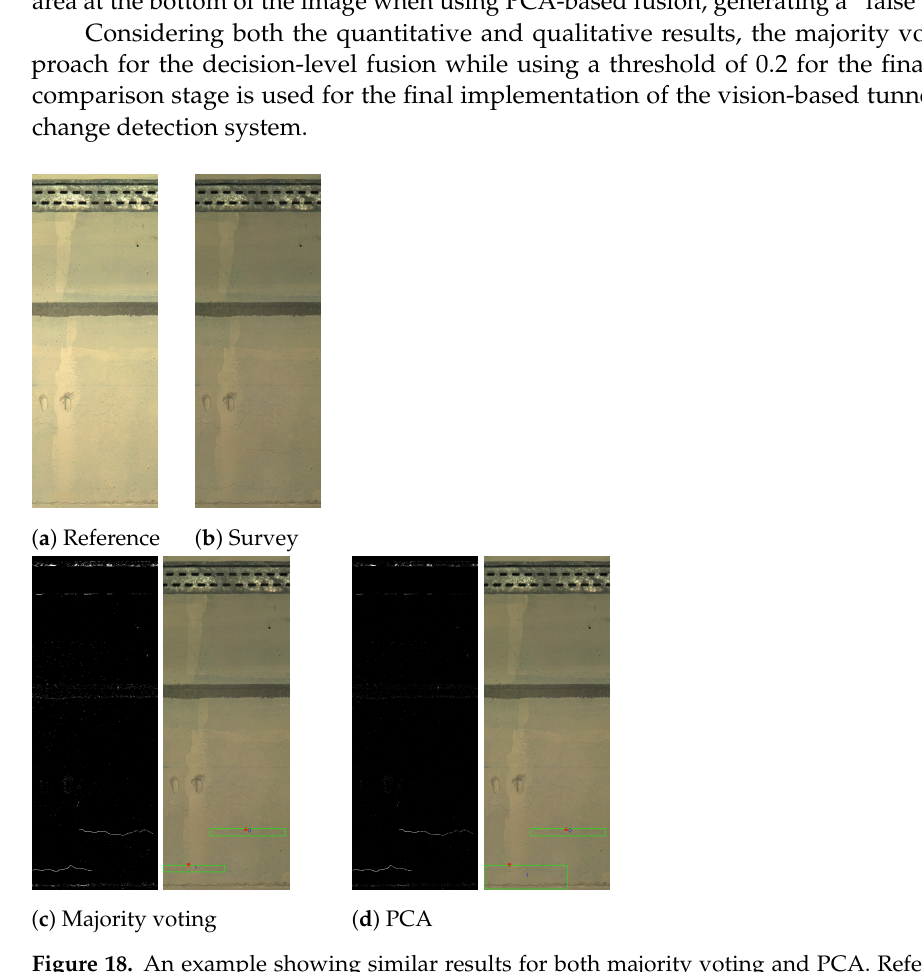
Figure 18. An example showing similar results for both majority voting and PCA. Reference ( a ), survey ( b ), majority voting ( c ) and PCA ( d ).